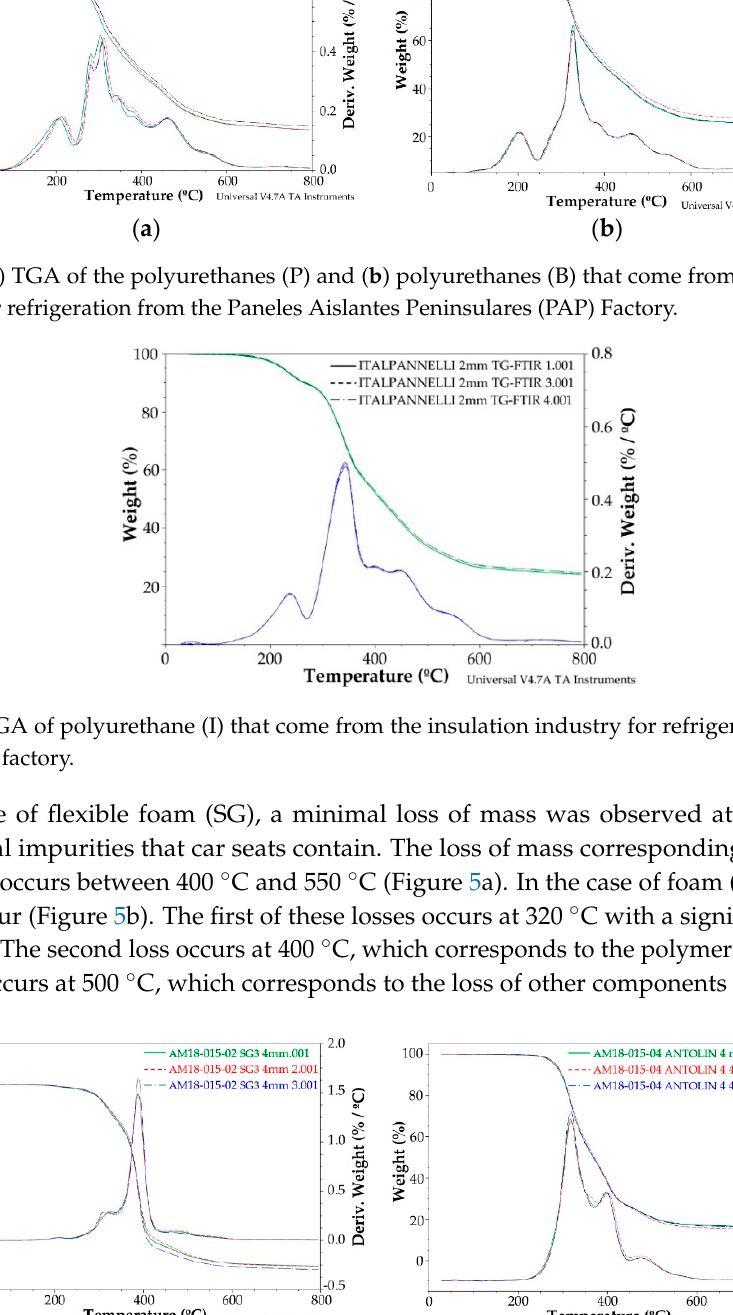
Figure 5. ( a ) The TGA of polyurethanes (SG) and ( b ) polyurethanes (A) that come from the insulation industry for refrigeration, from the Paneles Aislantes Peninsulares factory.